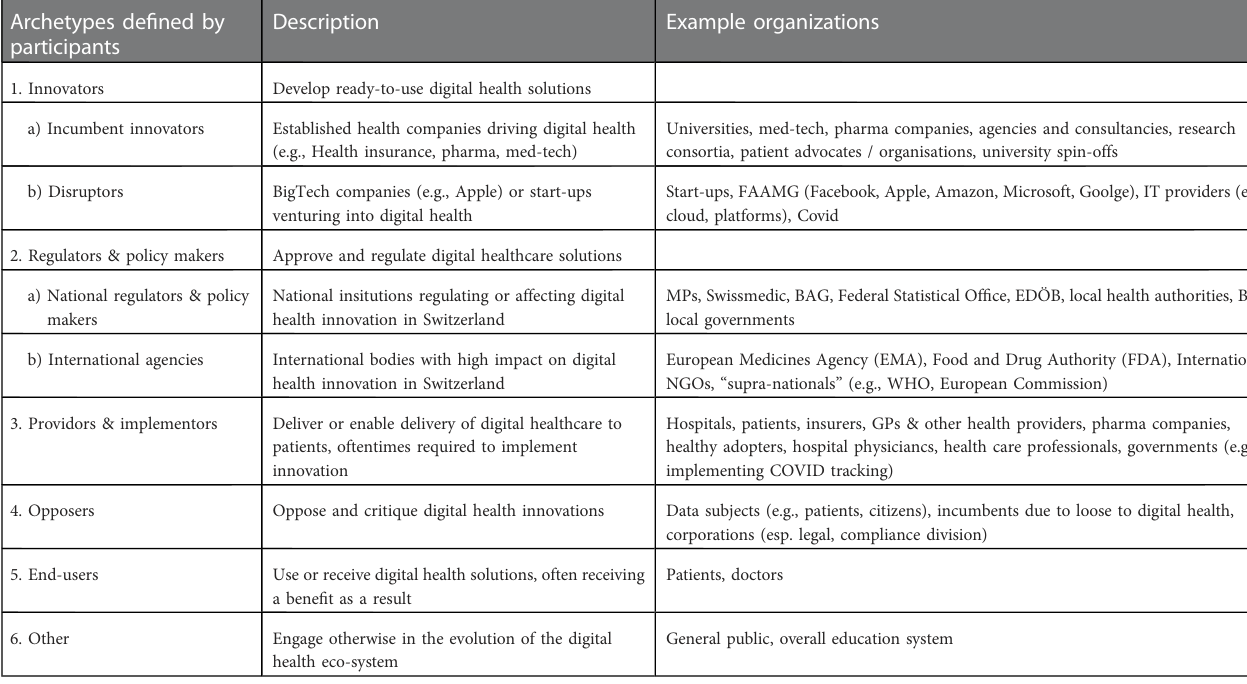
TABLE 2 Stakeholder archetypes de fi ned by participants*. Archetypes de fi ned by